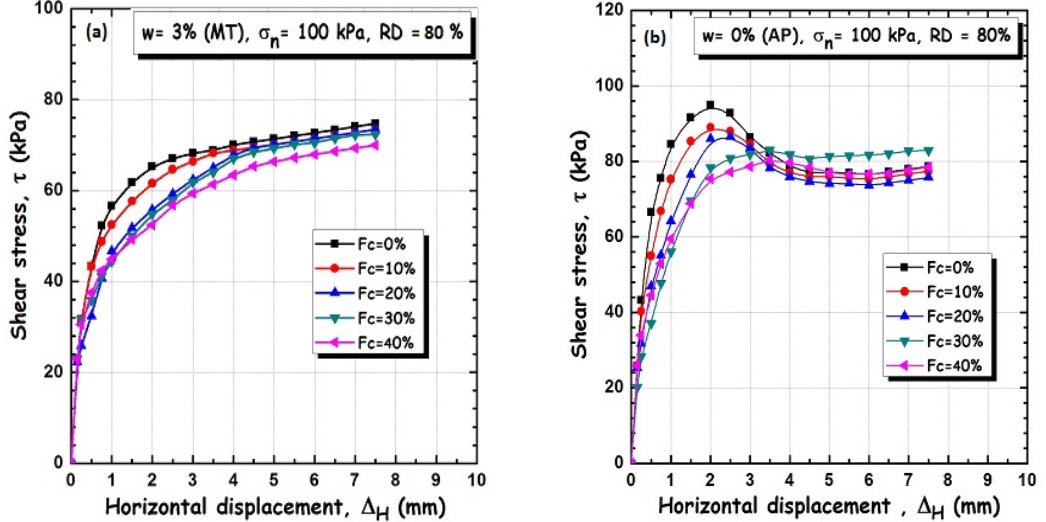
= 100 kPa): (a) variation of the shear n